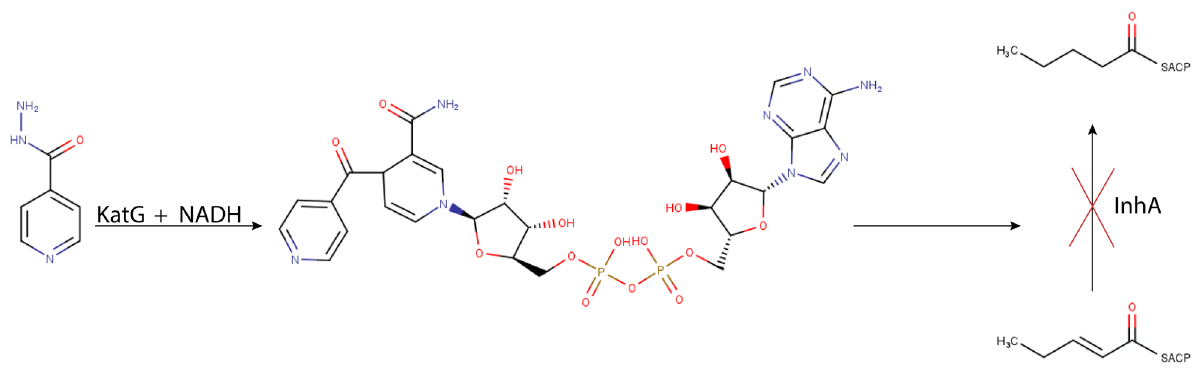
Figure 3 - InhA inhibition by INH-NAD adduct. Mechanism of action of InhA and inhibition by INH. KatG activates INH to produce the adduct INH- NAD adduct, which is formed through a reaction with NADH. InhA is inhibited by INH-NAD adduct, which blocks the fatty acid elongation catalyzed by the FAS-II system. Adapted from Vilchèze and Jacobs